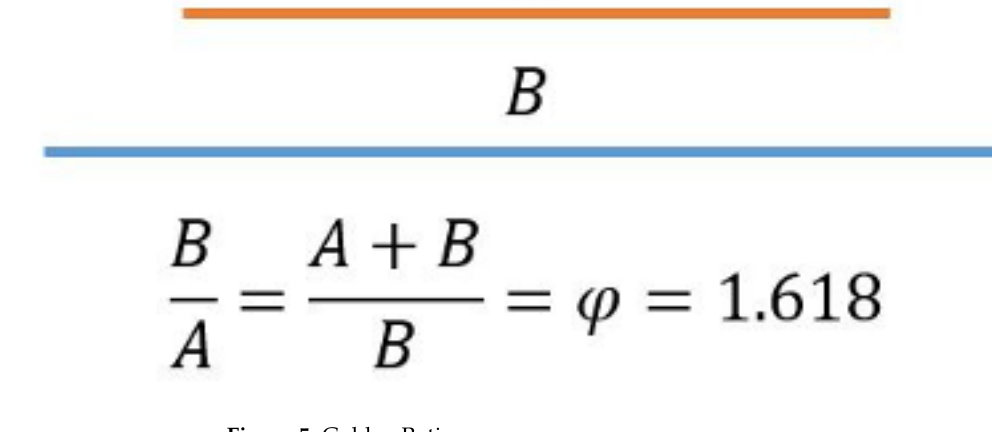
Figure 5. Golden Ratio.